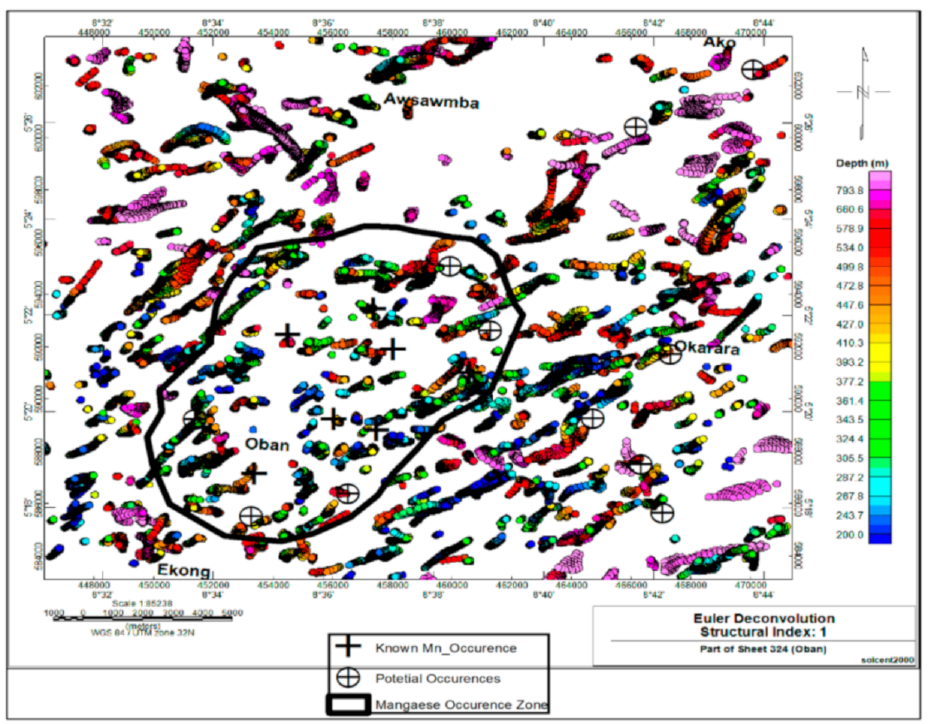
Figure 16. Standard Euler decomposition (structural index = 1.0; max. % depth tolerance = 5, window size = 10) with known and potential occurrence zones in the study